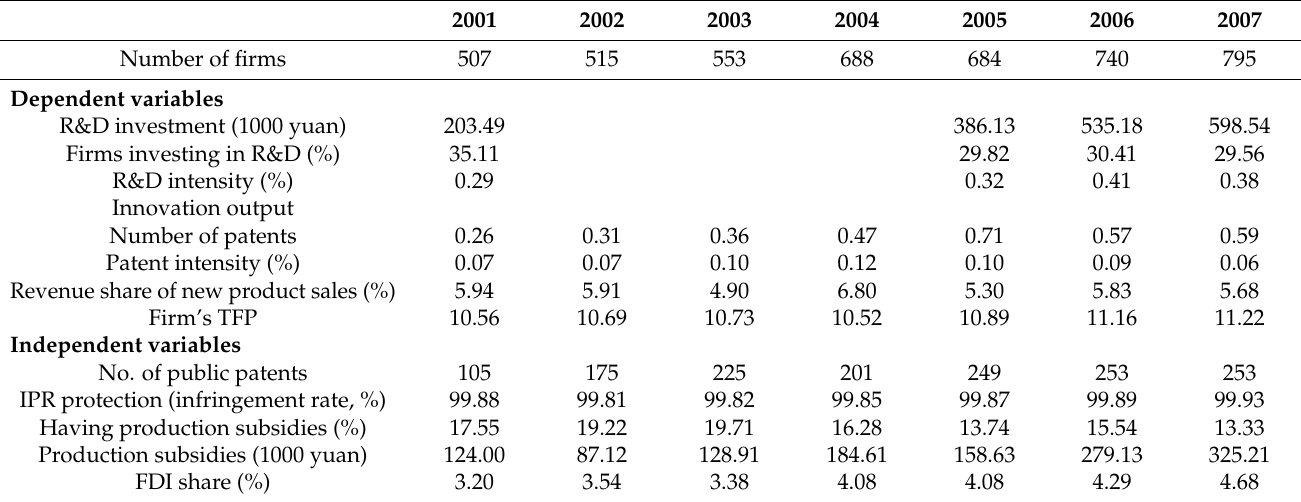
Table 2. Summary statistics of key variables by year.